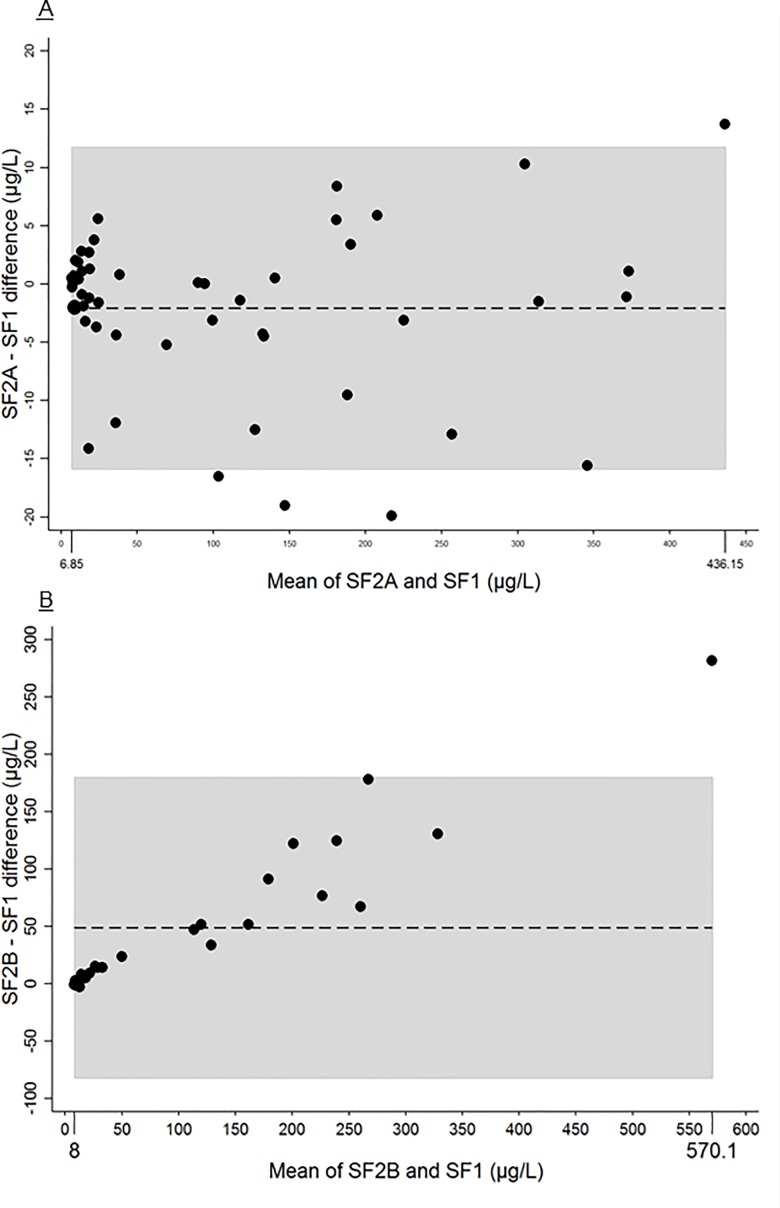
A. Bland-Altman graph: mean of serum ferritin (SF) at the first (SF1) and second measure without intermediate thawing (SF2A). Dotted line: mean difference between values of SF1 and SF2A. Grey zone: 95% limits of agreement for mean difference between SF1 and SF2A.
pB. Bland-Altman graph: mean of serum ferritin (SF) at the first (SF1) and second measure with intermediate thawing (SF2B). Dotted line: mean difference between values of SF1 and SF2B. Grey zone: 95% limits of agreement for mean difference between SF1 and SF2B.